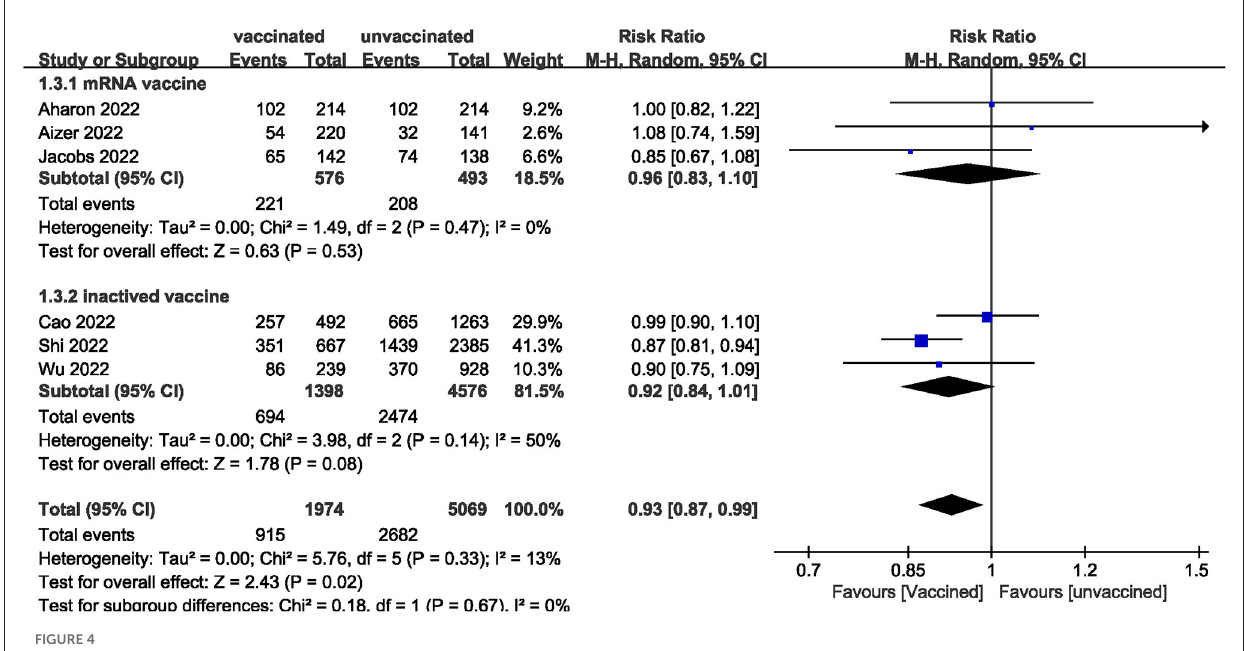
FIGURE4 Forest plot of ongoing pregnancy rate for vaccinated vs. unvaccinated.